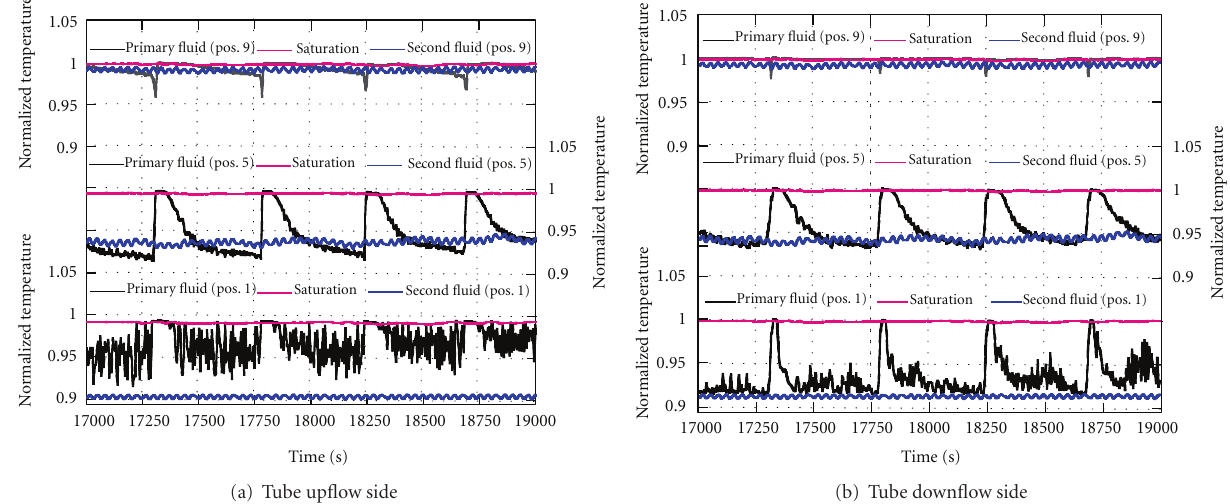
Figure 16: LSTF results for fluid temperatures in primary and secondary side of SG Tube 3 in loop with PZR at Positions 1, 5 and 9 during large-amplitude level oscillation period.